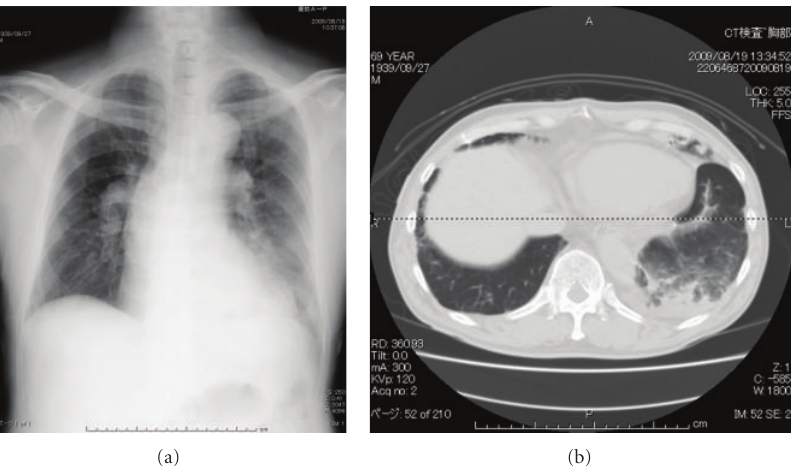
Figure 1: Chest X-ray and representative computed tomography image obtained on day 1. The patient had localized consolidation on his left lower lobe, suggesting postsurgical pulmonary edema in the dilated